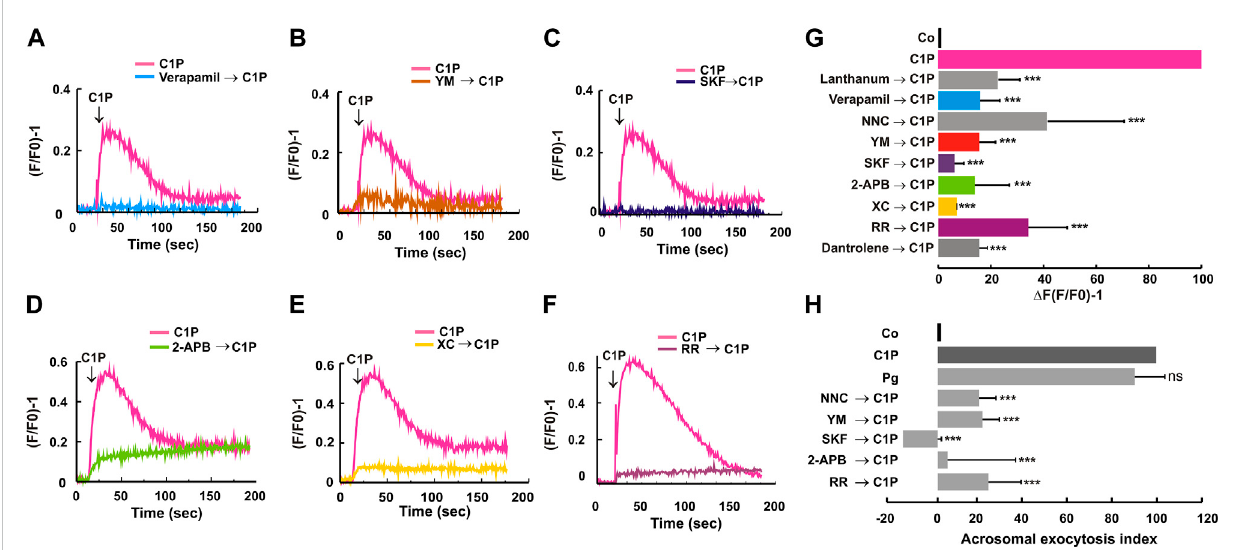
FIGURE 3 C1P-elicited intracellular Ca 2+ increase relies on extracellular calcium in fl ux and the ion release from intracellular stores. Capacitated human sperm recovered after swim-up were loaded with Fluo-3 AM (2 μ M), and the fl uorescence intensity was observed as described under “ Materials and Methods ” . Representativespatiotemporal[Ca 2+ ]ichangesandtheircorrespondingtracesareshown.Thearrowindicatestheadditionof10 μ MC1P.Whenindicated, cells were previously incubated for 10 min at 37 ° C with: (A) 100 μ M Verapamil, (B) 1 μ M YM-58483 (YM), (C) 50 μ M SKF-96365 (SKF), (D) 100 μ M